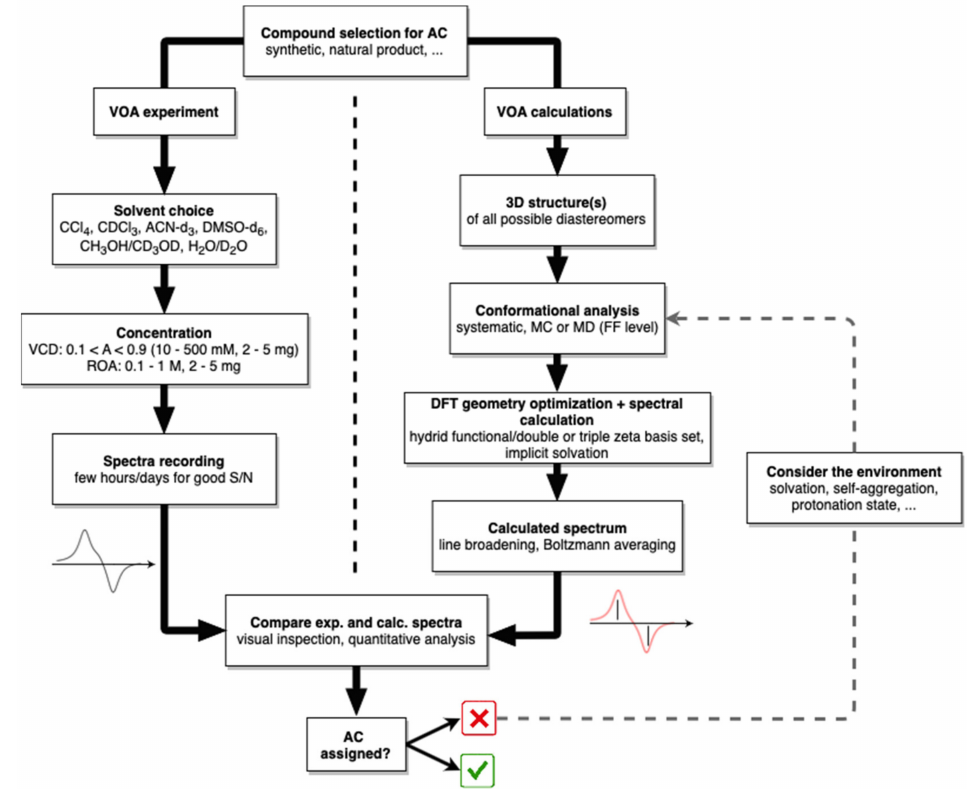
Figure 4. Typical workflow for AC determinations using VOA techniques. See text for more